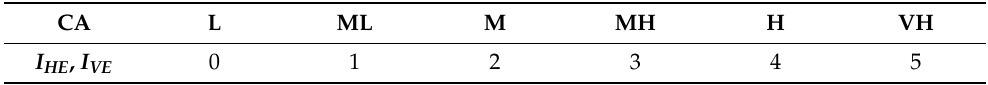
Table 7. Index of hazard I HE and vulnerability I VE